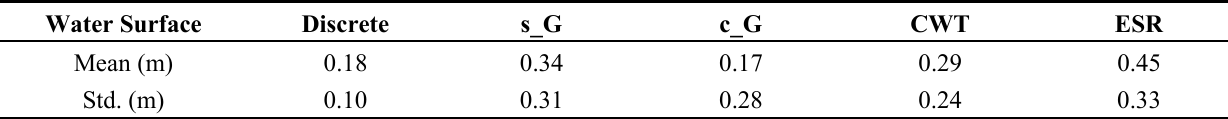
Table 3. Statistical mean vertical error and Std. for different green water surfaces. NIR water surface has an 11.76 cm Std.